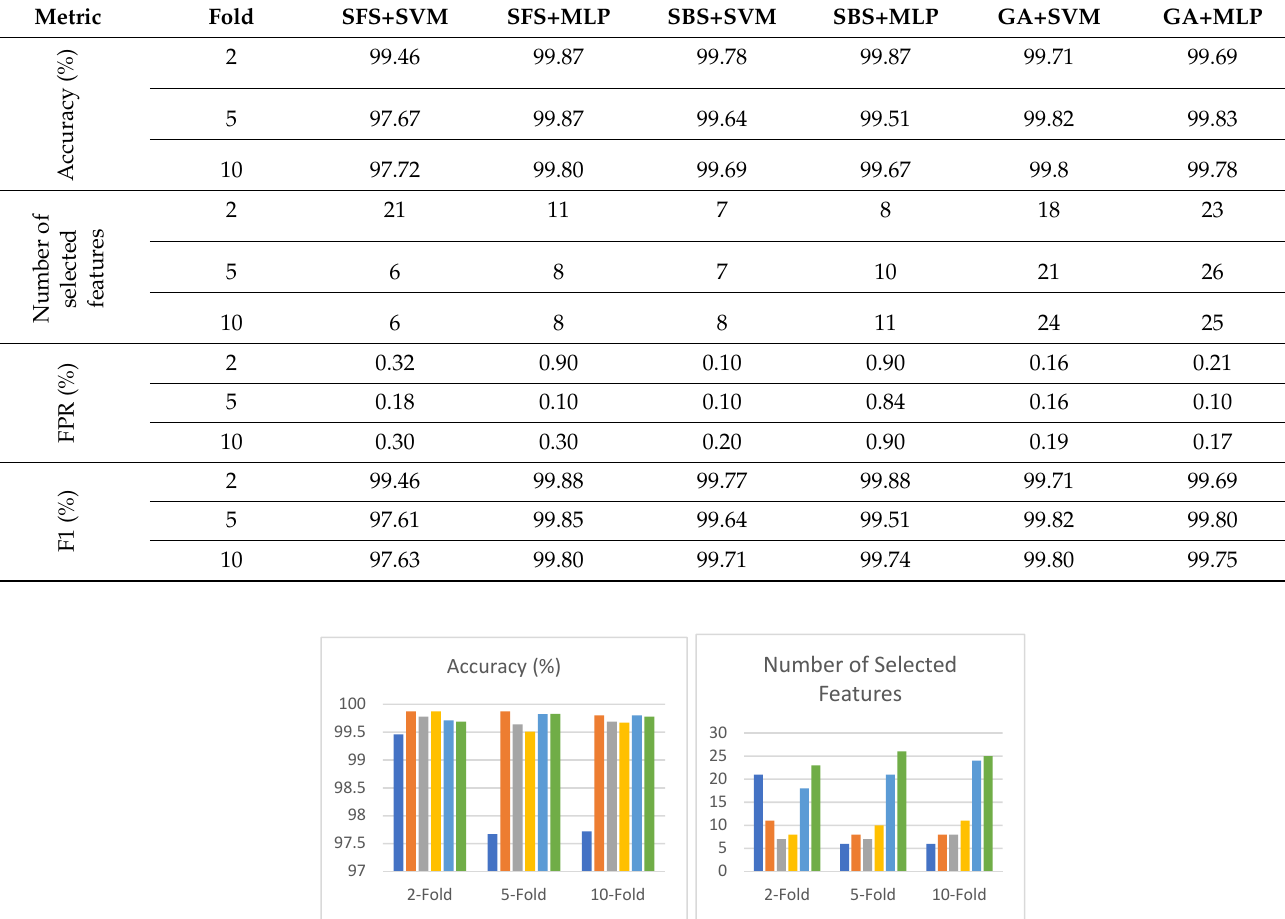
Table 8. Performance of SFS, SBS, and GA using objective function based on accuracy and number of selected features in CIC-IDS-2018.